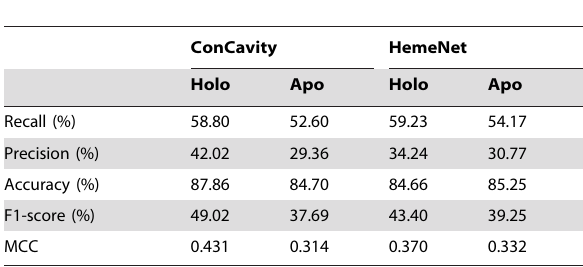
Table 7. Performance comparison of ConCavity and